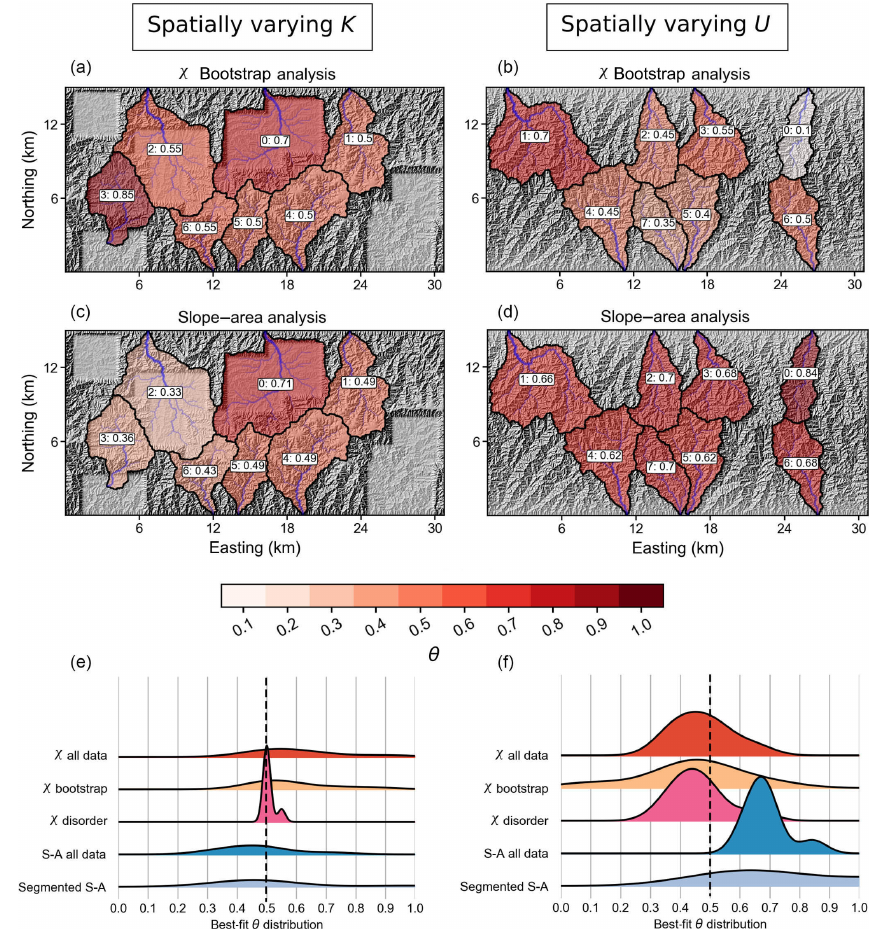
Figure 7. Results of the model runs with spatially varying erodibility ( K , a, c, e ) and uplift ( U , b, d, f ). The rectangular patches of low relief are areas of high erodibility in (a) , (c) , and (e) . Panels (a) – (d) show the spatial pattern of predicted θ from the χ bootstrap analysis and the slope–area analysis, where the basins are coloured by θ (darker colours indicate higher concavity index). Panels (e) and (f) show density plots of the distribution of θ for each method, where the dashed line marks the correct θ =